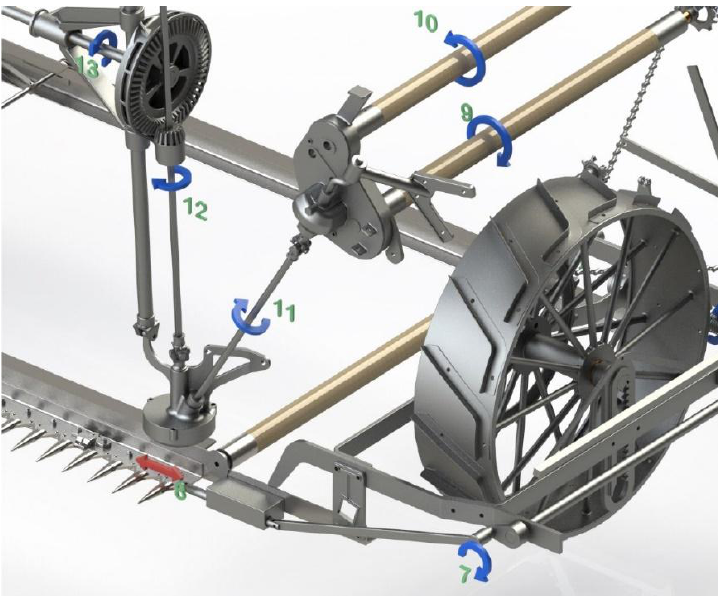
Figure 27. Description of the second set of elements of the transmission system.